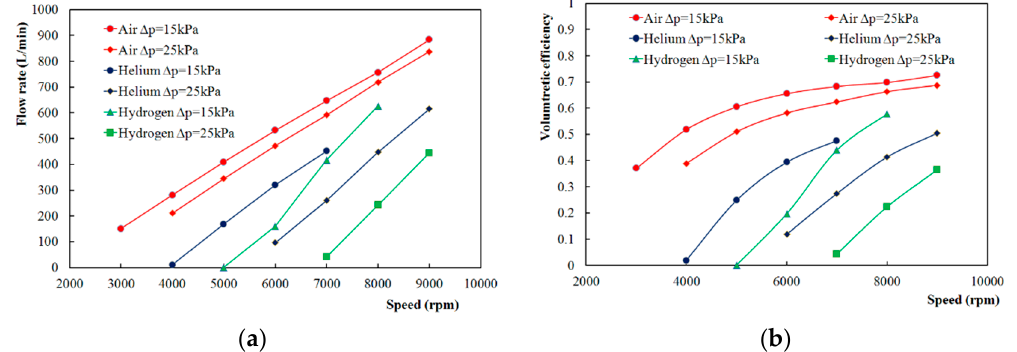
Figure 8. Comparison of performance with air, helium, and hydrogen: ( a ) flow rate; and ( b ) volumetric efficiency.